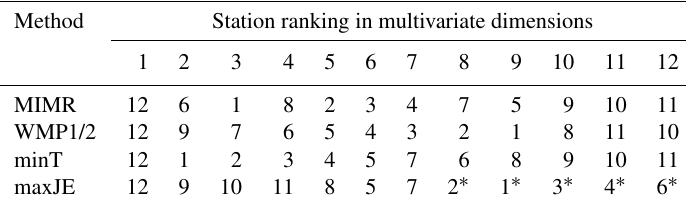
Table 3. Optimal gauge orders found with different methods for the Brazos River case study.